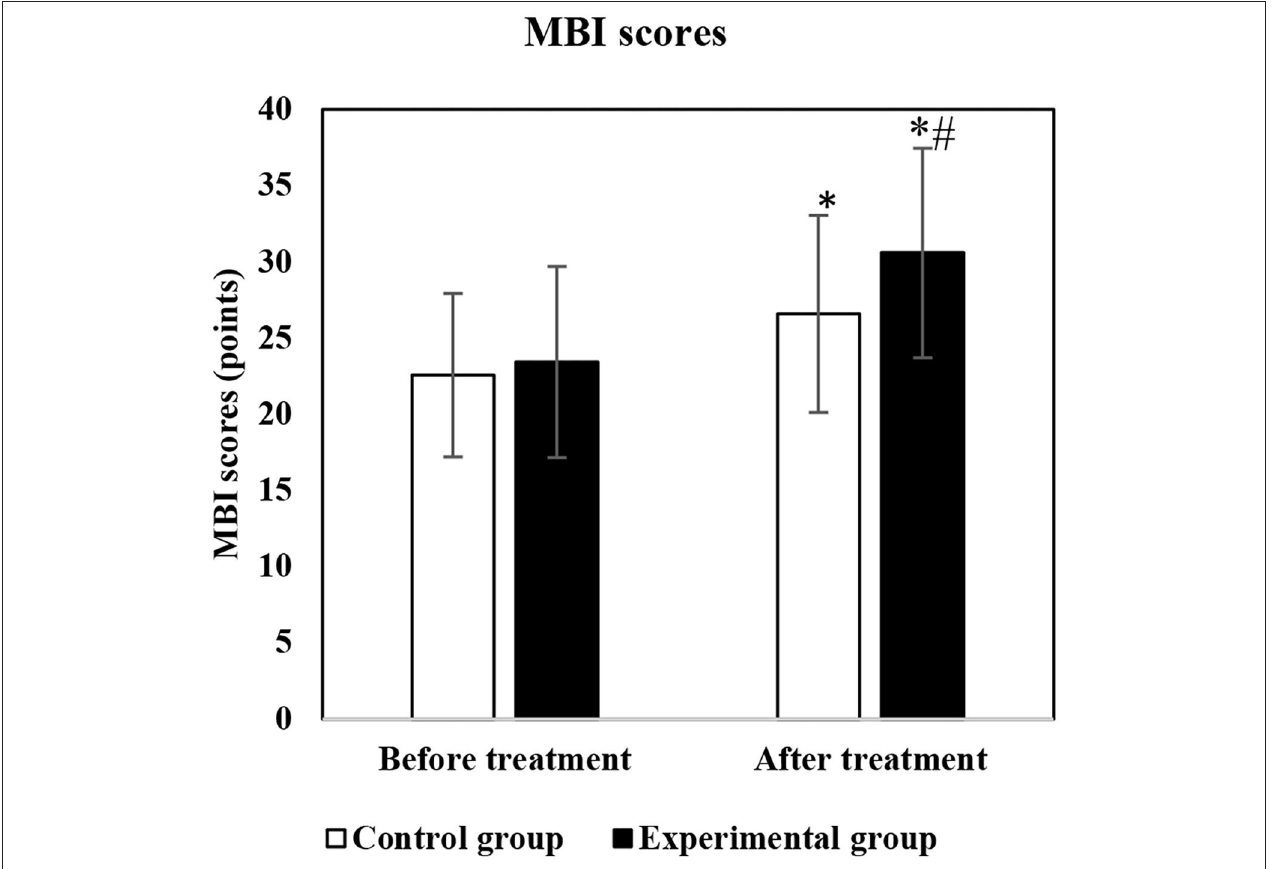
FIGURE 13 | Comparison of MBI scores before and after treatment. * and # indicated that statistically significant differences as the MBI score were compared with that before treatment and that of the control group, respectively ( p <